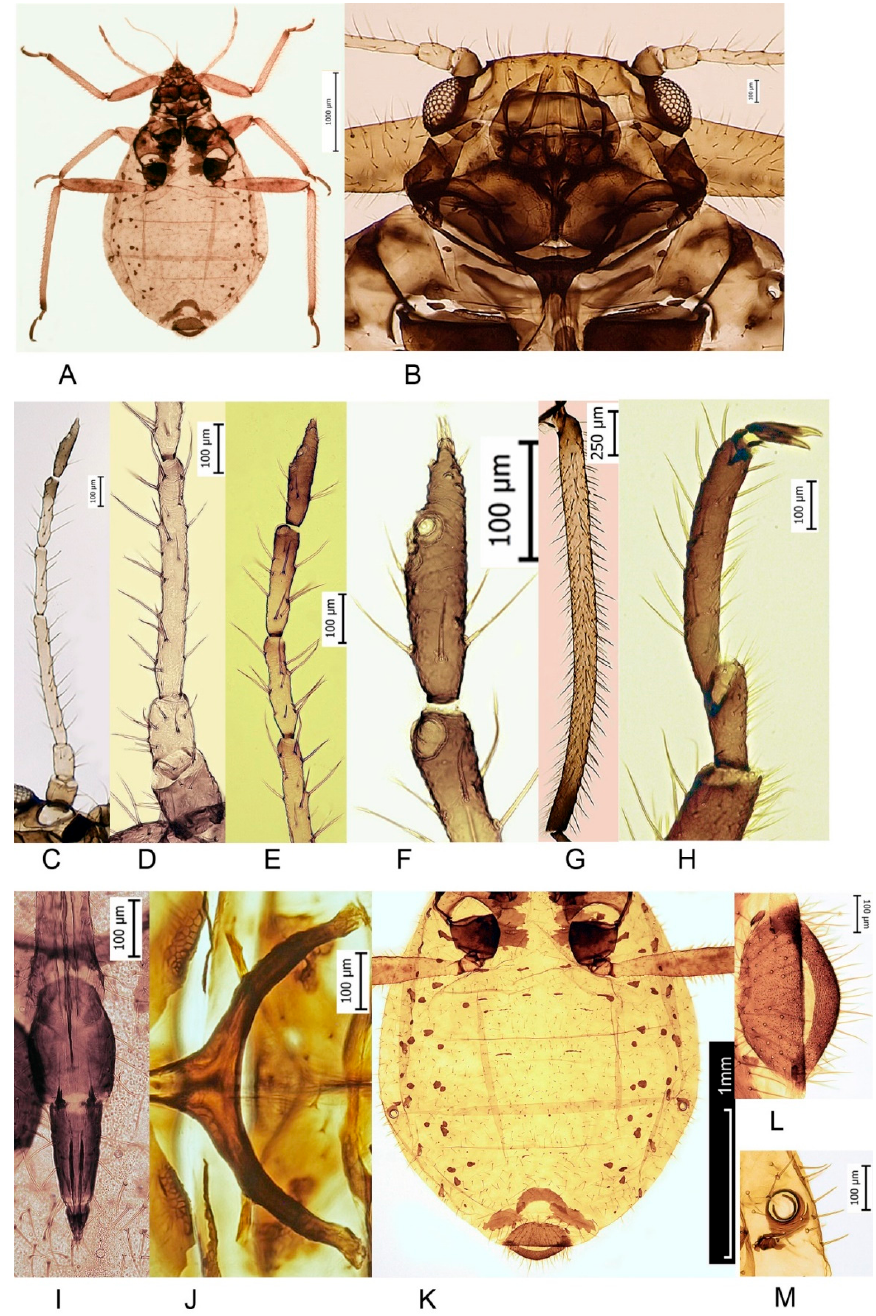
Figure 1. Cinara splendens (Gillette and Palmer, 1924) apterous viviparous female. ( A ) Whole body; ( B ) head; ( C ) antenna; ( D ) 1st–3rd segments of antenna; ( E ) 4th–6th segments of antenna; ( F ) 6th segment of antenna; ( G ) hind tibia; ( H ) hind tarsus; ( I ) 4th + 5th segments of rostrum; ( J ) furca of the mesothotax; ( K ) abdomen; ( L ) cauda; ( M ) siphunculus.